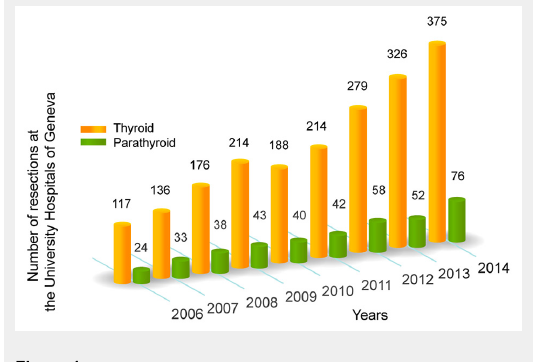
Number of operations on the thyroid and parathyroid glands performed in our centre during the last 8 years.